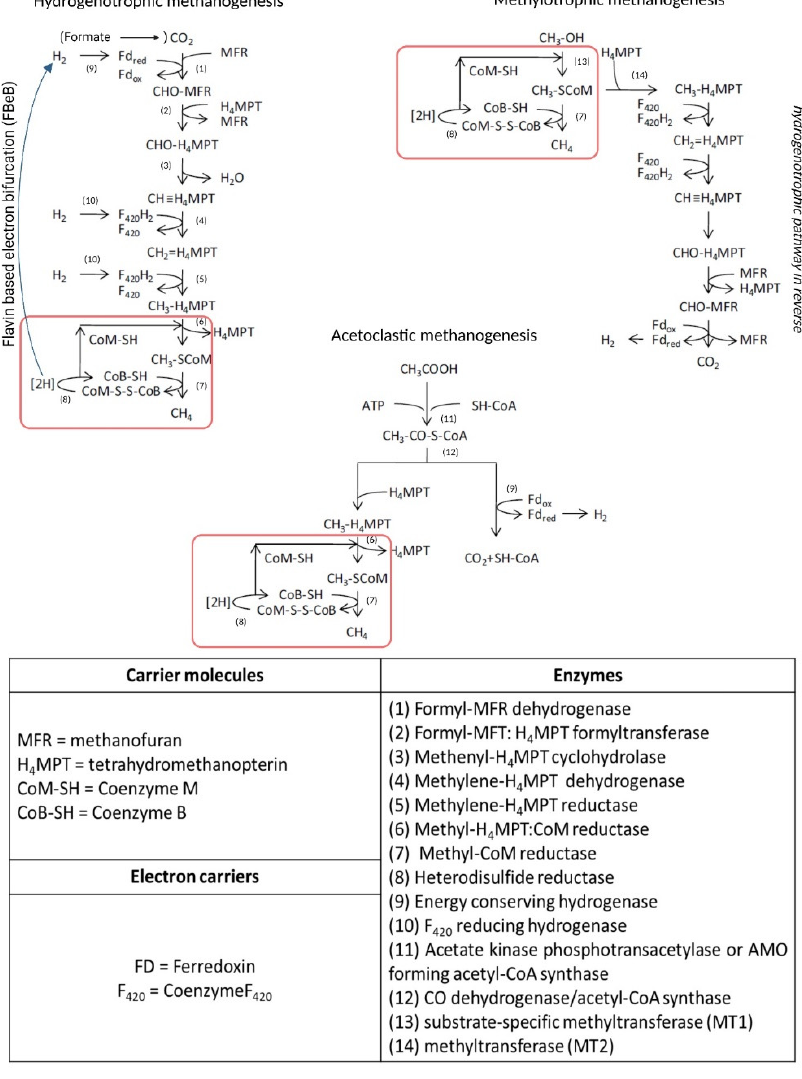
Figure 3. Metabolic pathways, enzymes and co-enzymes involved in methanogenesis. Red squares indicate metabolic reactions common to all three methanogenic pathways. Adapted from